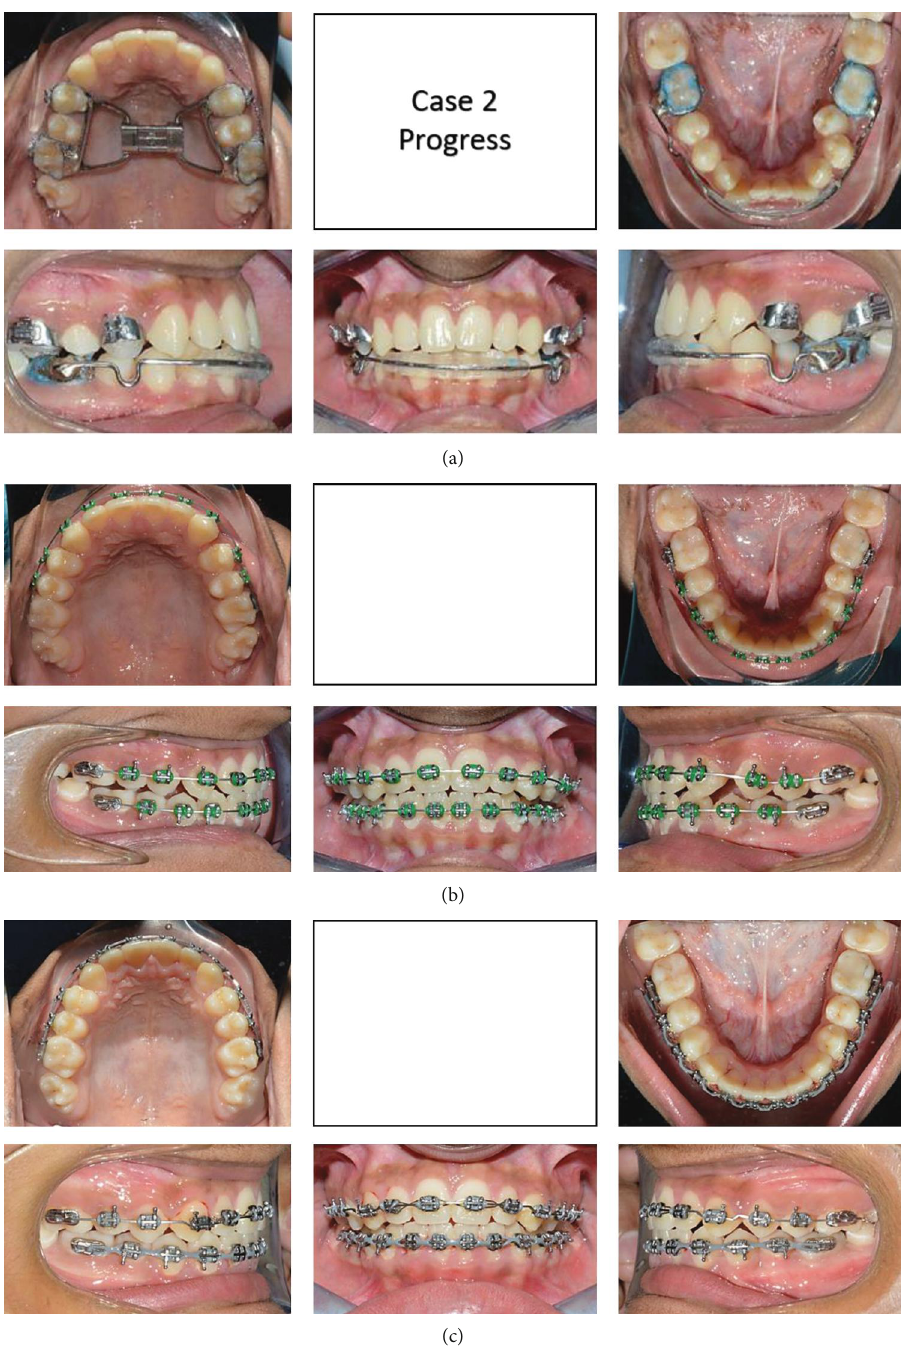
Figure 9: (a – c) Progress treatment intraoral photographs of the